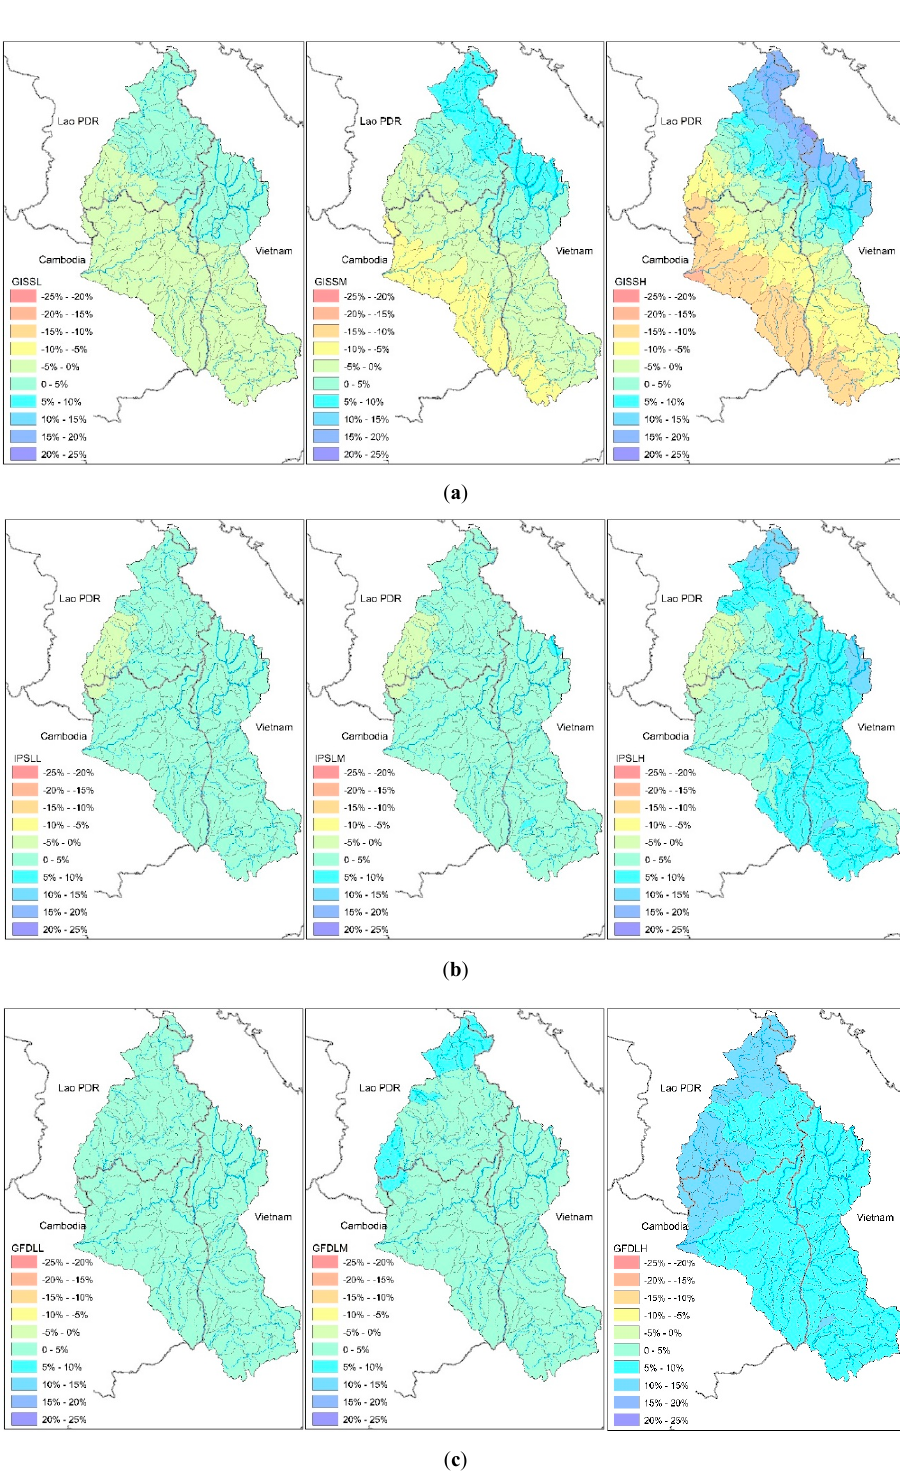
Figure 5. Percentage (%) change in annual precipitation under three emissions scenarios (L—low, M—medium and H—high emissions) for GCMs: ( a ) GISS model, ( b ) IPSL model and ( c ) GFDL model for 2051–2070 compared to the base line climate for period